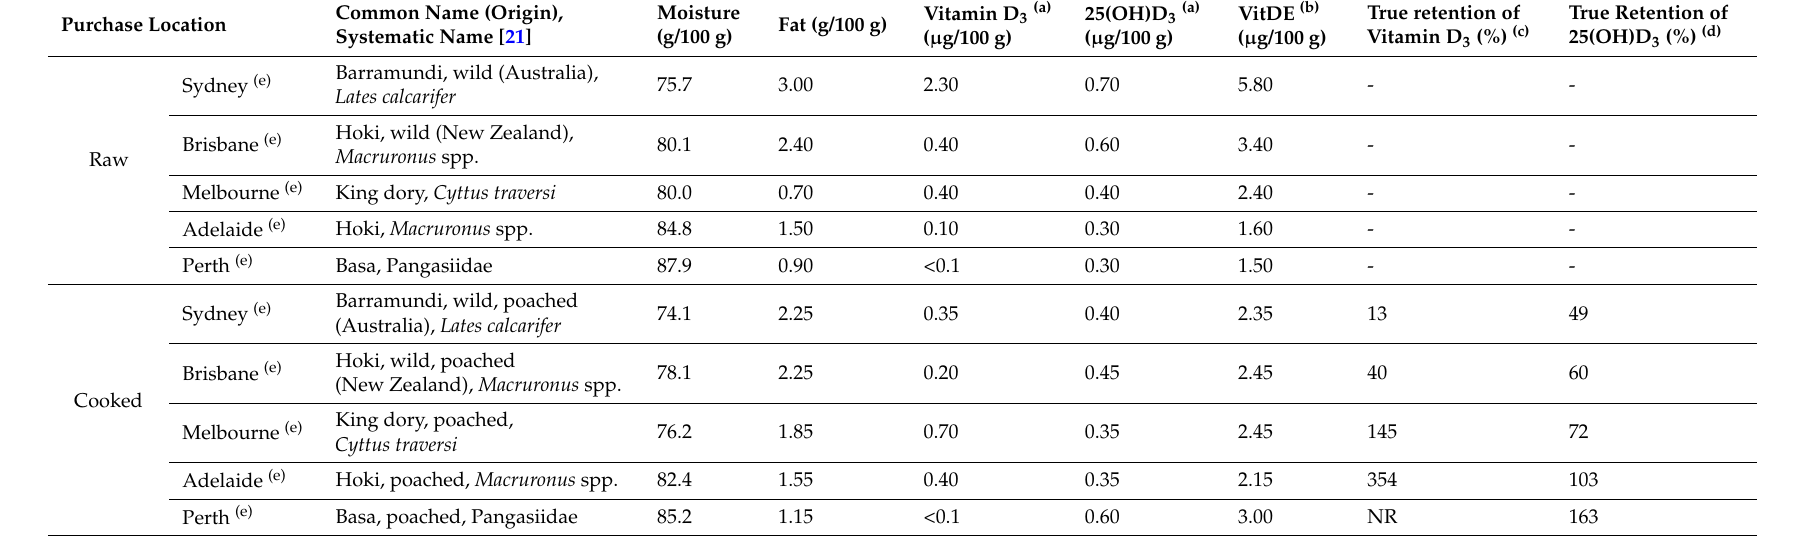
Table 2. New data for moisture, fat, vitamin D 3 , 25-hydroxyvitamin D 3 and vitamin D equivalents in white